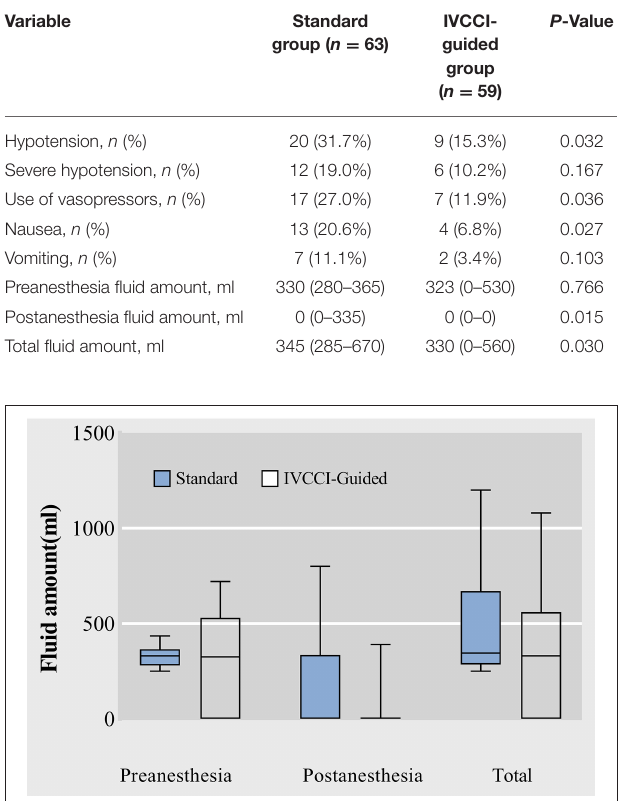
TABLE 3 | Patient’s baseline data in IVCCI-guided group and the standard group. TABLE 4 | Patient’s outcomes in IVCCI-guided group and the standard group.